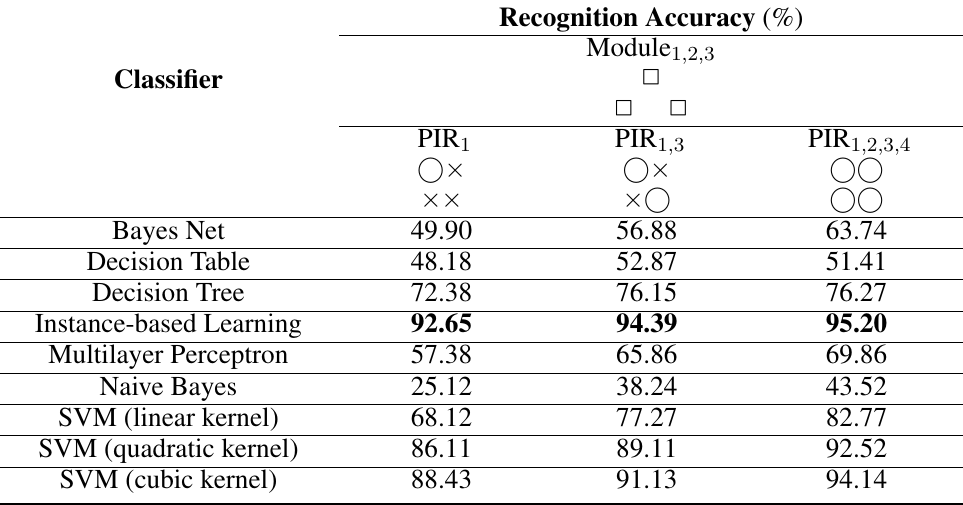
Table 7. Comparison of the recognition accuracy (%) of identifying walking subjects based on the raw data set with respect to the number of PIR sensors of all modules.